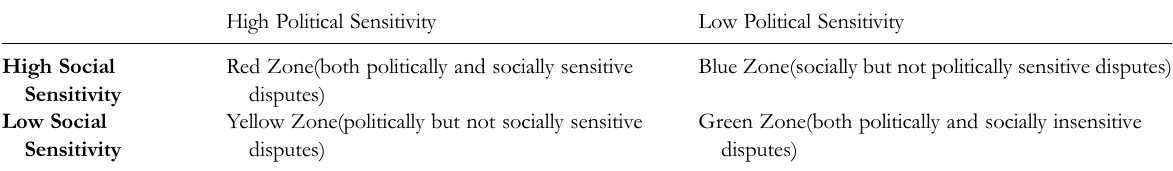
Table 1: Simpli fi ed Categorization of Investment